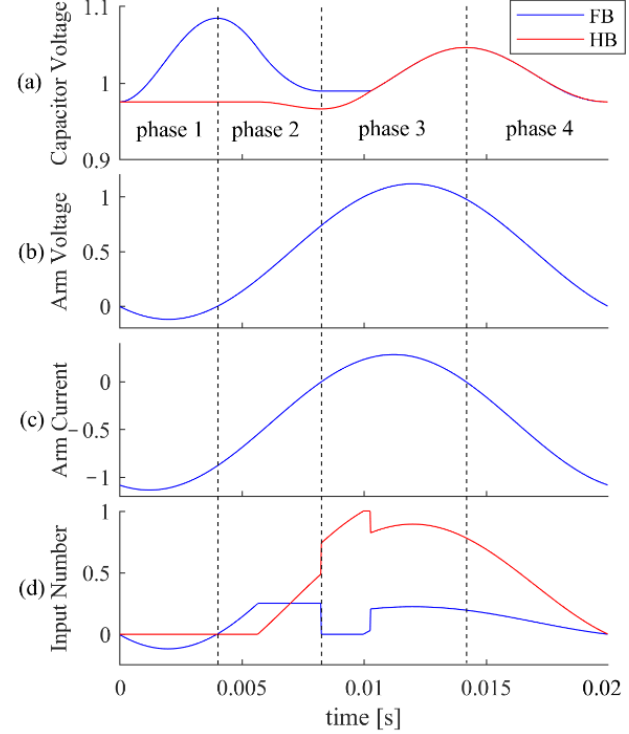
Figure 6. Illustration of capacitor voltage variation process: ( a ) capacitor voltages; ( b ) arm voltage; ( c ) arm current; ( d ) input submodule number.